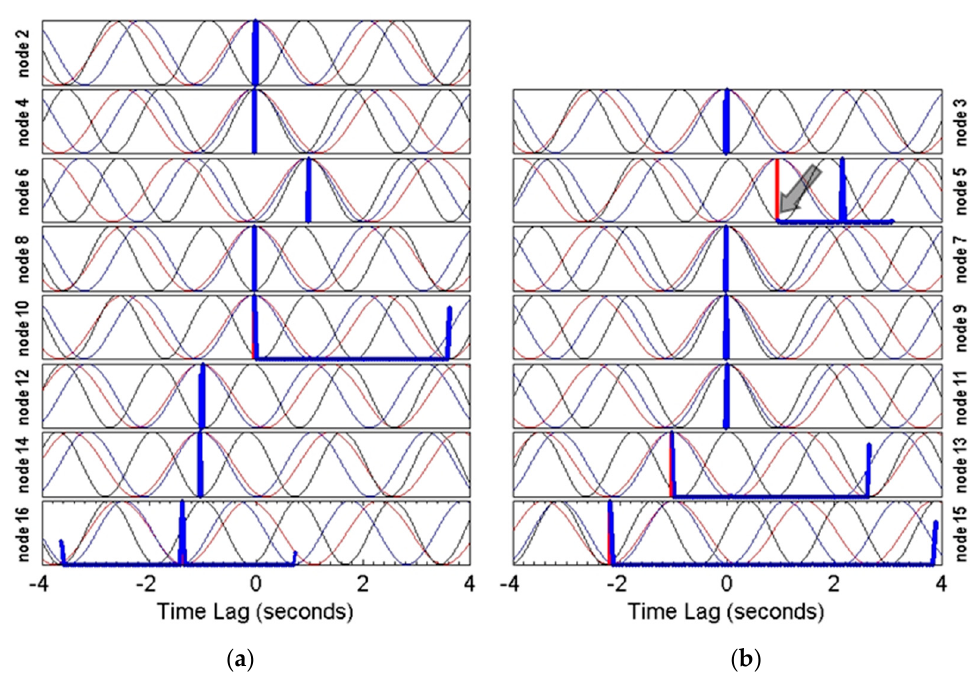
Figure 19. PATL ( a ) and KDF ( b ) plots for all nodes in the building. The arrow shows the second ranked solutions for node #5.